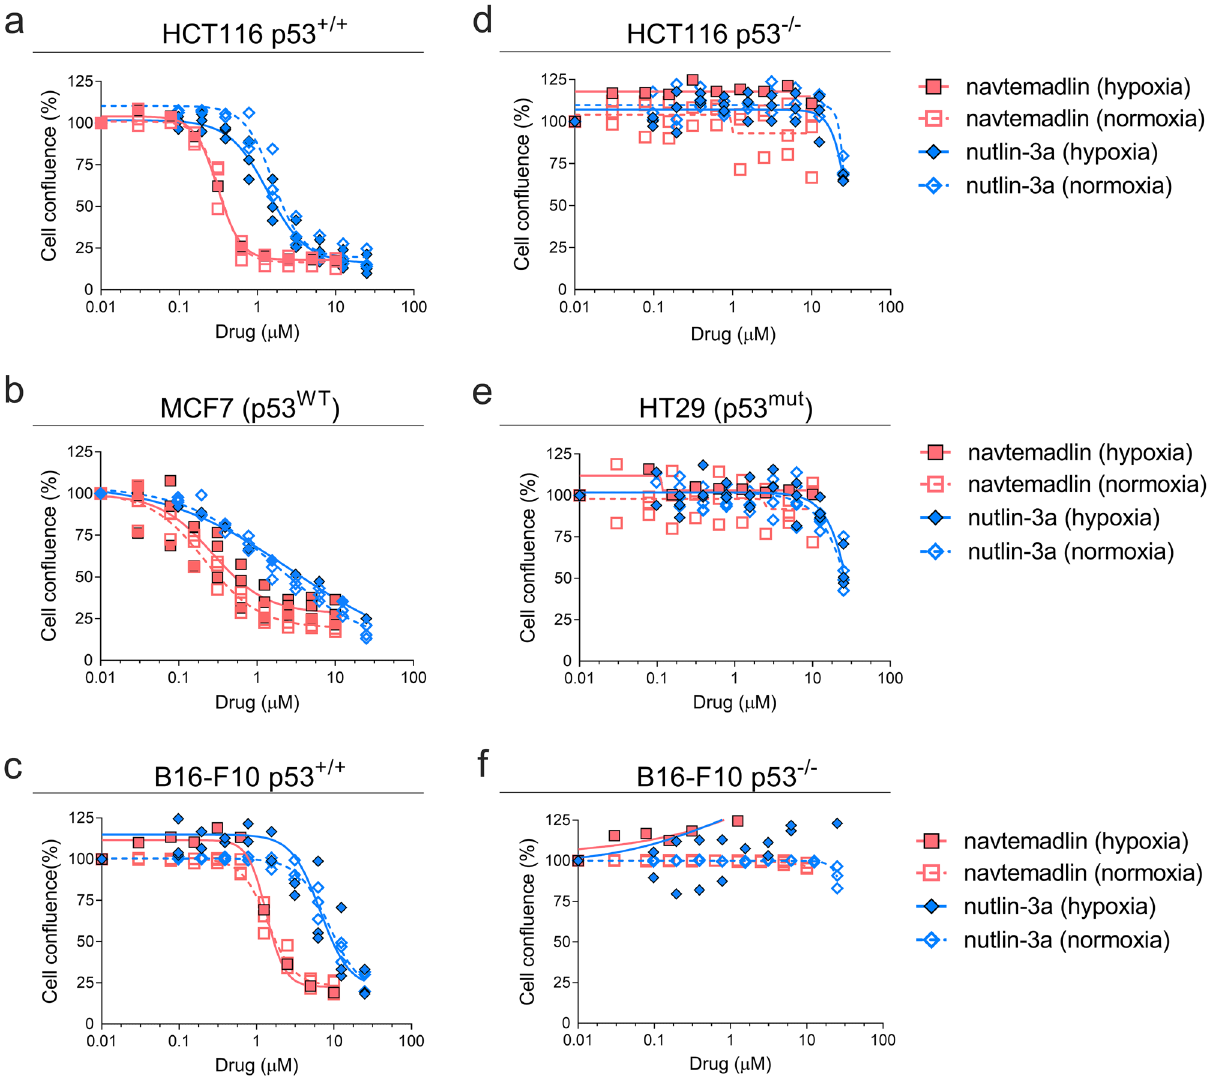
Figure 1. MDM2 inhibitors, nutlin-3a and navtemadlin, inhibit the growth of p53 wildtype (p53 WT ) cancer cell lines cultured in hypoxia (1% O 2 ). ( a–c ) Concentration-growth curves of three p53 wildtype cell lines (human HCT116 p53 +/+ , human MCF7, and mouse B16-F10 p53 +/+ ) in normoxic and hypoxic conditions. ( d–f ) Concentration-growth curves of three p53 knockout and mutant cell lines (human HCT116 p53 −/− , human HT-29 p53 mut , and mouse B16-F10 p53 −/− ) in normoxic and hypoxic conditions. Cell growth (as assessed by percent confluence normalised to untreated wells) was measured after 72 h of treatment with MDM2 inhibitors. Each data point represents the averaged value of triplicates from one independent experiment (n = three independent experiments). The line indicates the best fit model for concentration-growth response.